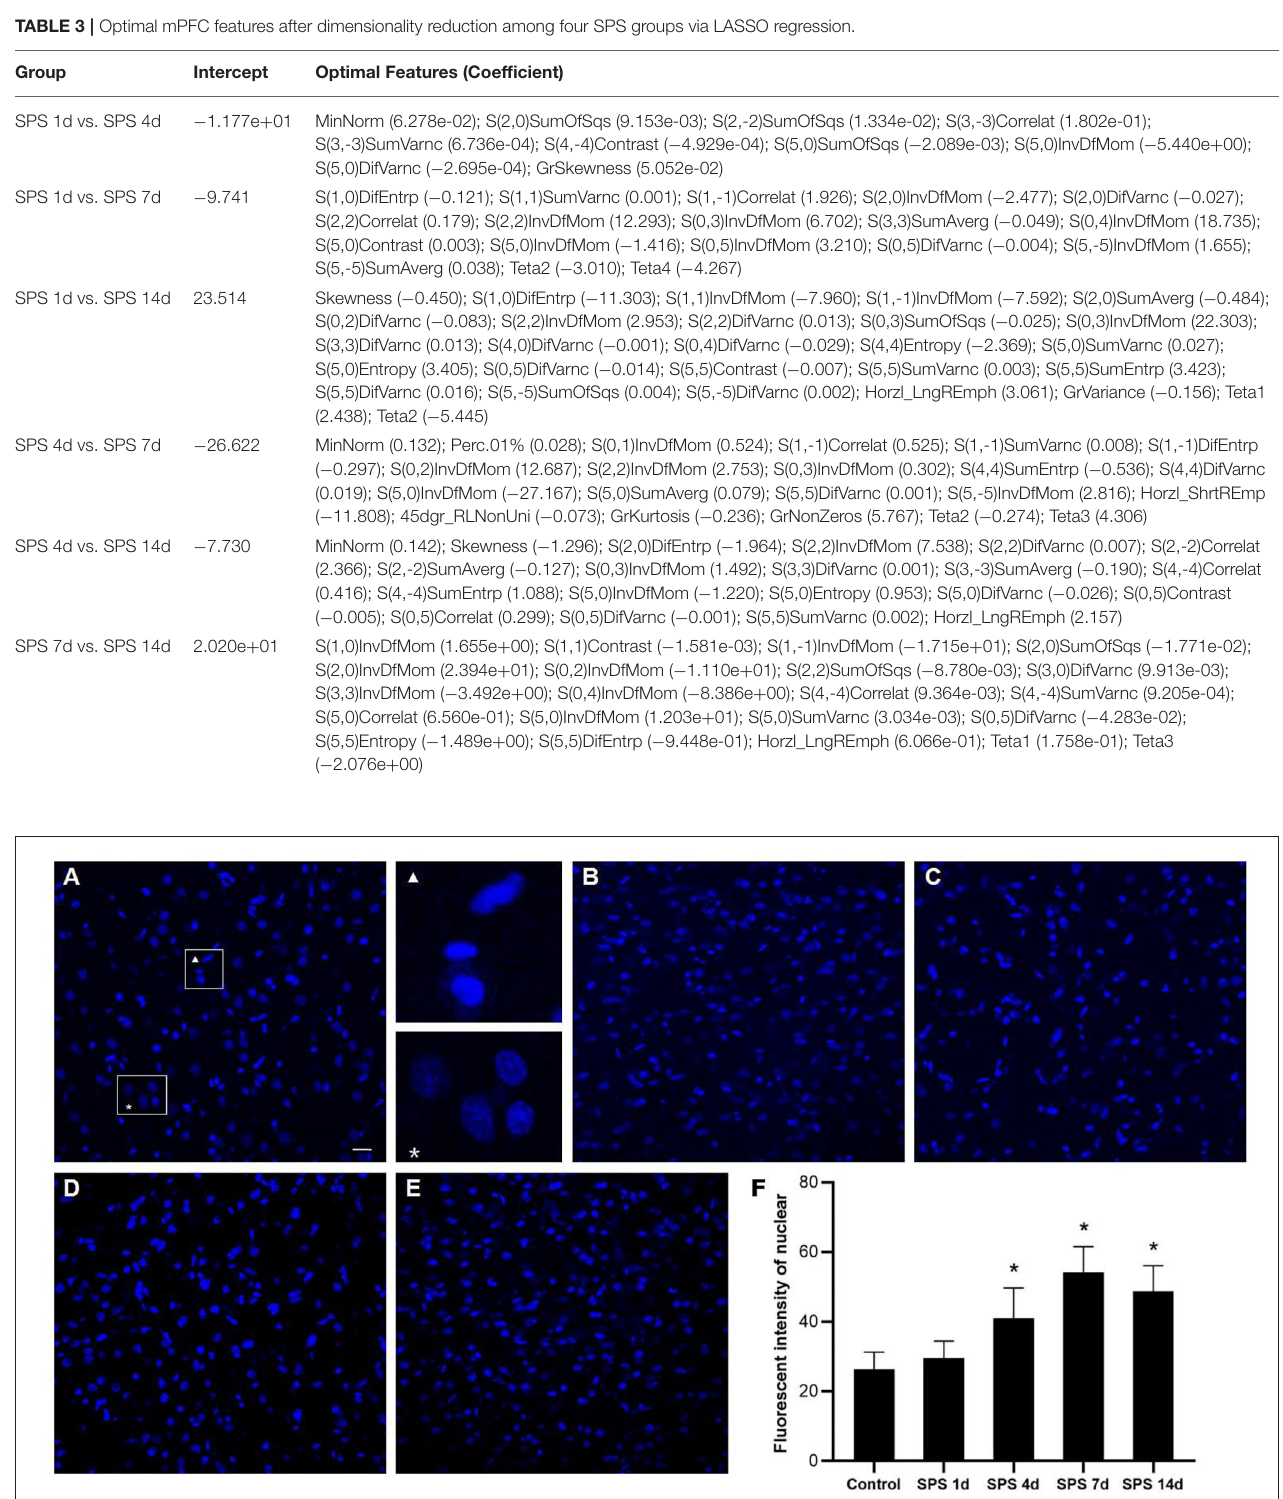
FIGURE 6 | mPFC DAPI immunostaining. Representative photomicrographs of DAPI immunostaining are shown in (A–E) (magnification × 400, Bar = 20 µ m): (A) control group; (B) SPS 1d; (C) SPS 4d; (D) SPS 7d; (E) SPS 14d. The normal and abnormal cellular nuclei are shown in the right part of panel (A) . Quantitative analysis of fluorescence intensity of cell nuclei in mPFC is shown in panel (F) . * P < 0.05 vs. control group.